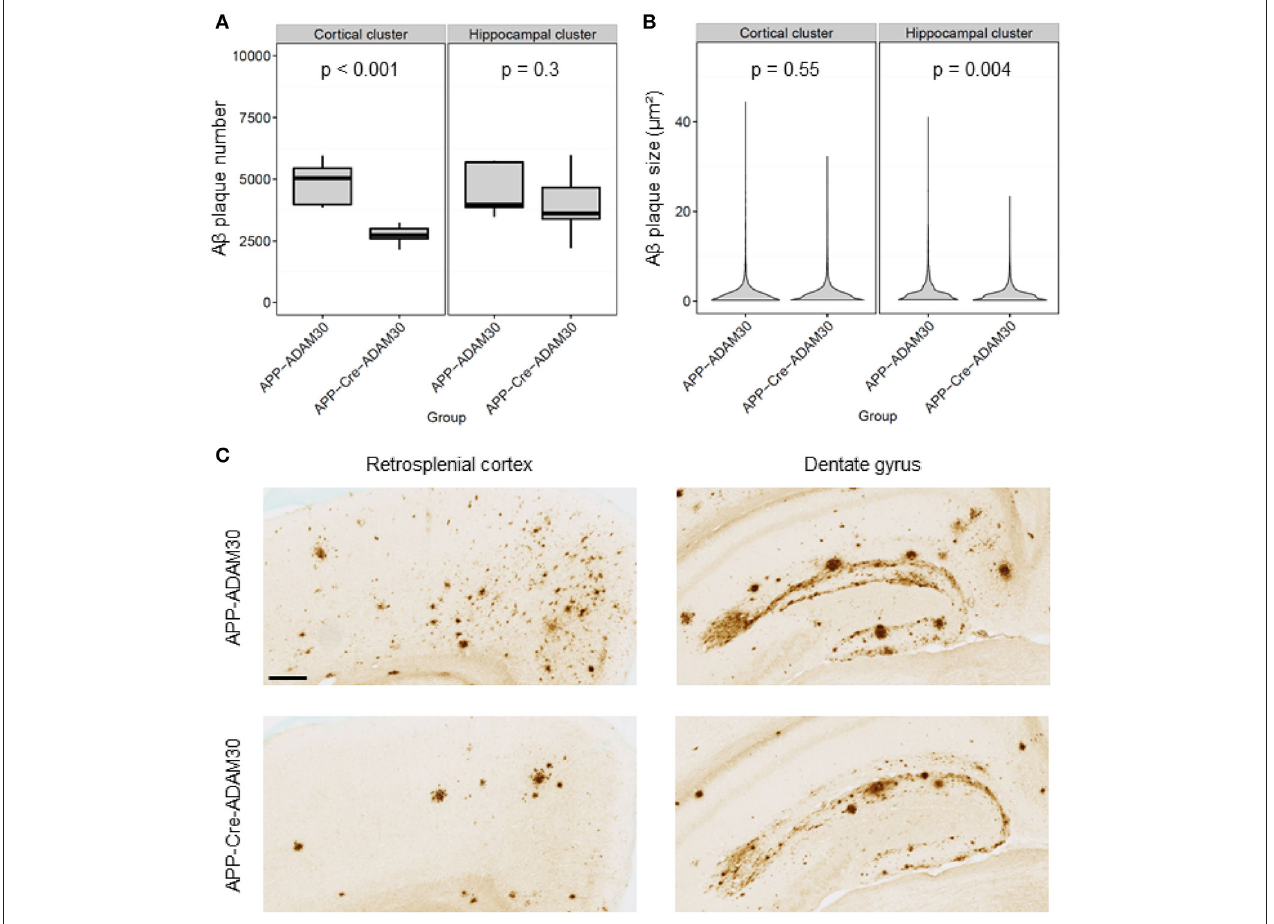
FIGURE 7 | Comparisons of A β plaque number and size between APP Swe , Ind -ADAM30 and APP Swe , Ind -Cre-ADAM30 mice. (A) Boxplot with A β plaque number within the cortical and the hippocampal clusters. (B) Violin plot showing the distribution of A β plaques size within the cortical and the hippocampal clusters. (C) Zooms in 6E10 stained-tissue section images in the retrosplenial cortex and the dentate gyrus for both groups (scale bar: 200 µ